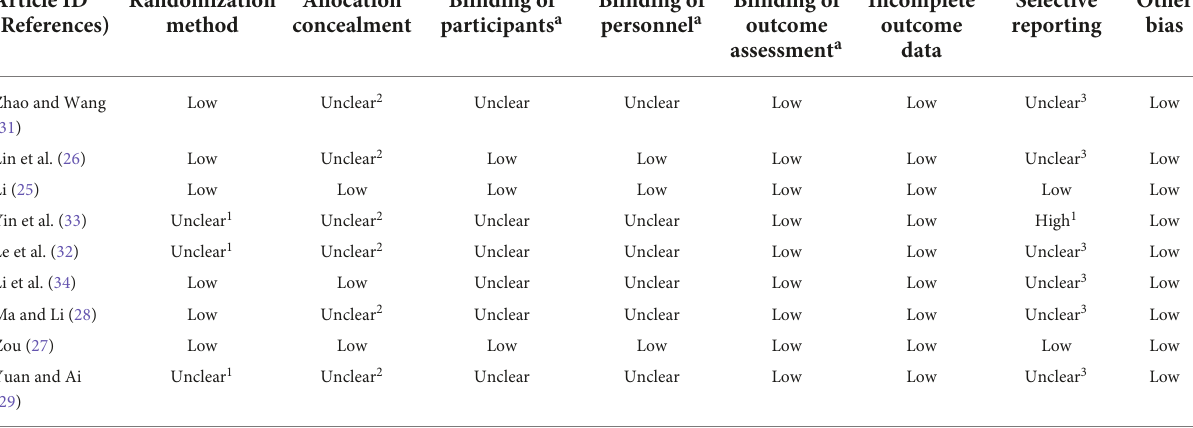
TABLE 2 Risk of bias